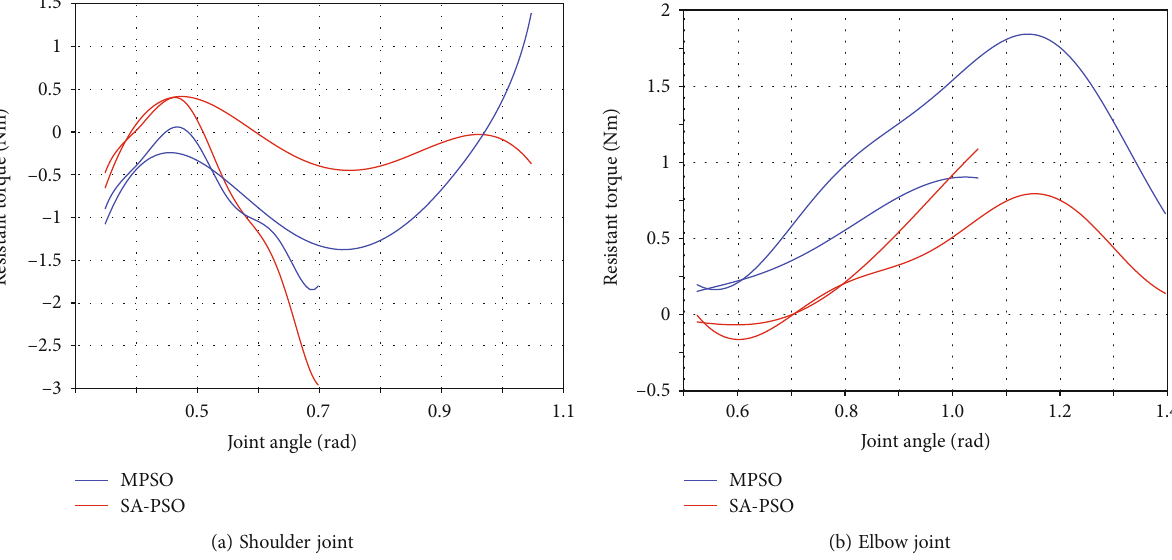
Figure 8: Prediction errors of the J-A model with di ff erent PSO algorithms for upper limb